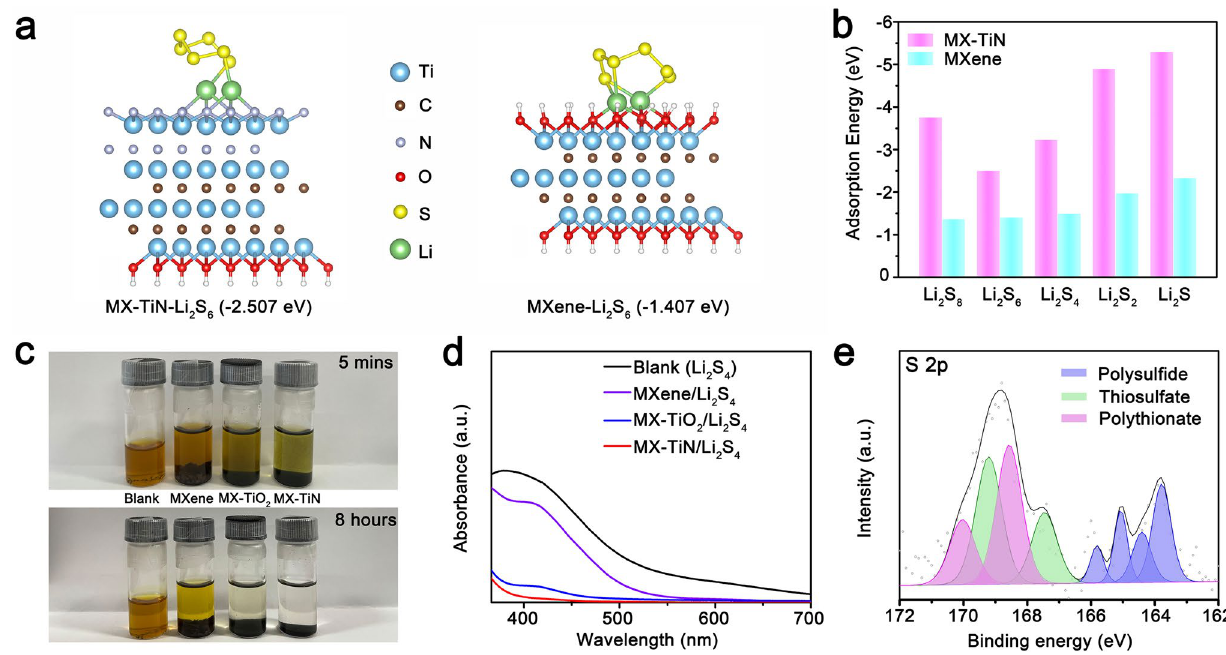
Fig. 3 a Optimized configurations of Li 2 S 6 on MX‑TiN and Ti 3 C 2 T x MXene. b Adsorption energies of different LiPSs species on MX‑TiN and Ti 3 C 2 T x MXene. c Optical photographs of pure Li 2 S 4 solution, and MXene/Li 2 S 4 , MX‑TiO 2 /Li 2 S 4, and MX‑TiN/Li 2 S 4 dispersions at 5 min and 8 h. d UV–Vis spectra of Li 2 S 4 solutions after exposure at different adsorbents for 8 h. e S 2 p XPS profile of MX‑TiN/Li 2 S 4 after soaking for 8